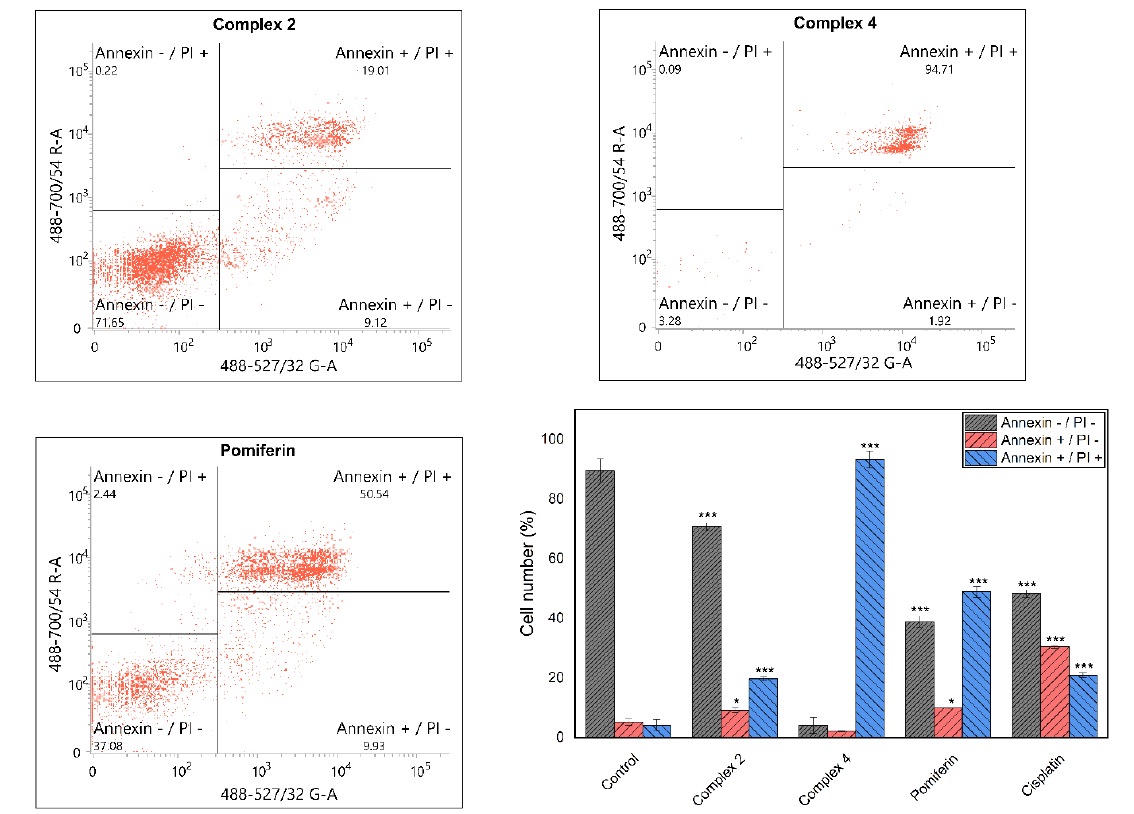
Figure 3. Induction of different types of cell death caused by the complexes 2 and 4 , pomiferin and cisplatin at the concentration of 15 µ M after 24 h incubation. The significant change in the number of cells in a specific phase of the cell cycle caused by the respective complex as compared to the untreated control is symbolized by * at p ≤ 0.05 level, and *** at p ≤ 0.0001 level.